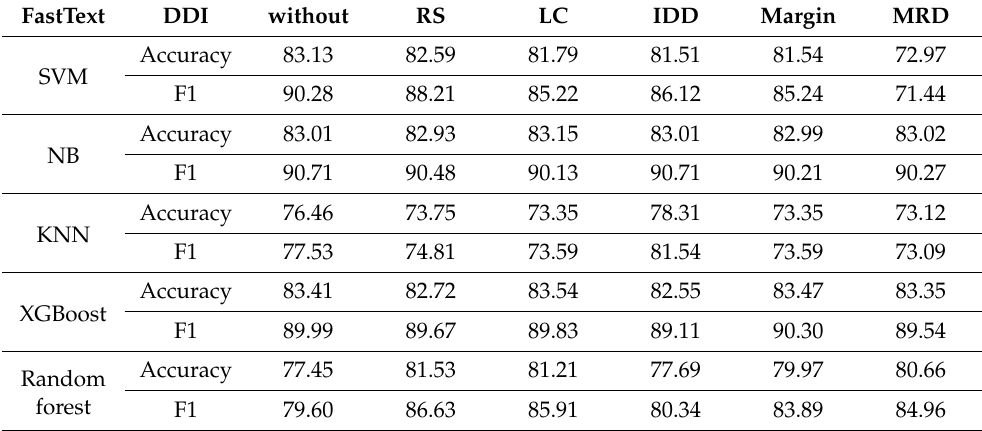
Table 5. Comparison of results with and without AL methods (FastText) for DDI